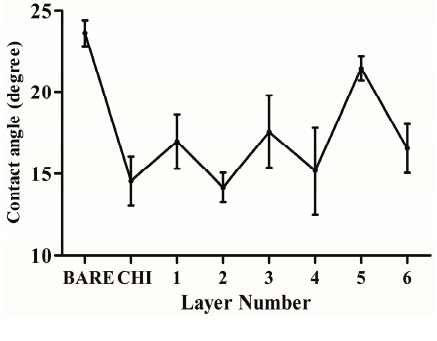
Figure 1. Water contact angles as a function of the number of coating layers. The even layer numbers correspond to DNA layers, and the odd layer numbers correspond to hyaluronic acid (HA) layers ( n = 9).